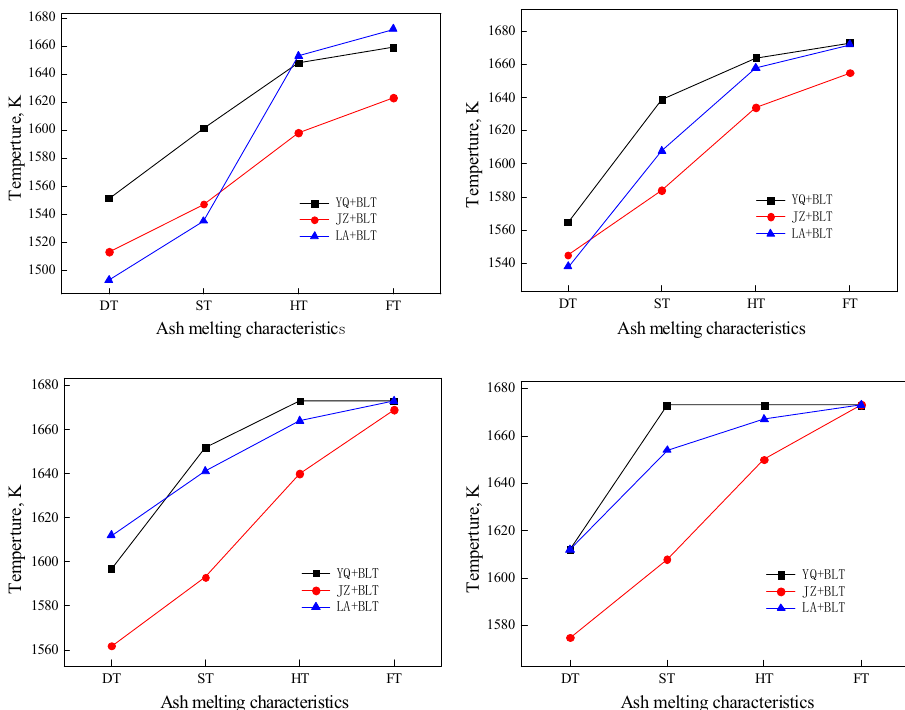
Figure 2: Variation of four kinds of ash melting characteristic temperature with coal type under various ratio conditions: ( a ) mixed ratio = 5:5, ( b ) mixed ratio = 6:4, ( c ) mixed ratio = 7:3, and ( d ) mixed ratio = 8:2.